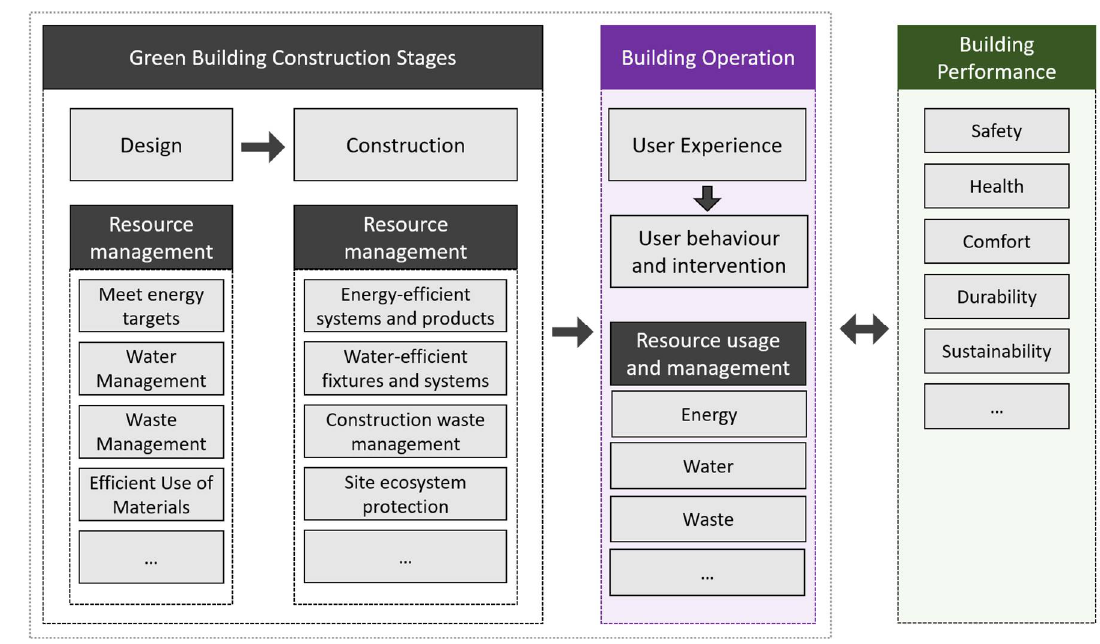
Figure 1. Building recourse management at different stages.